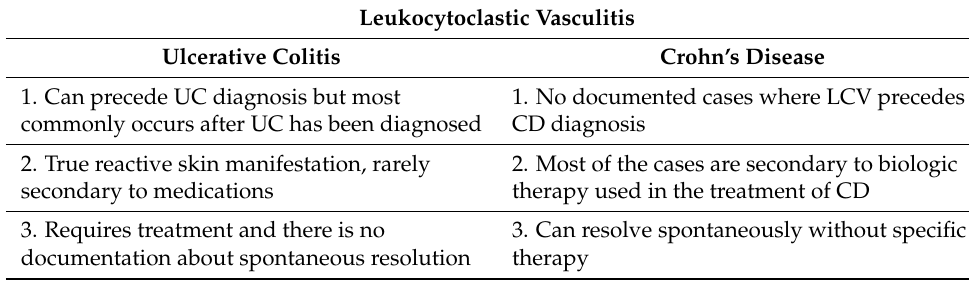
Table 3. Comparison of LCV in UC and